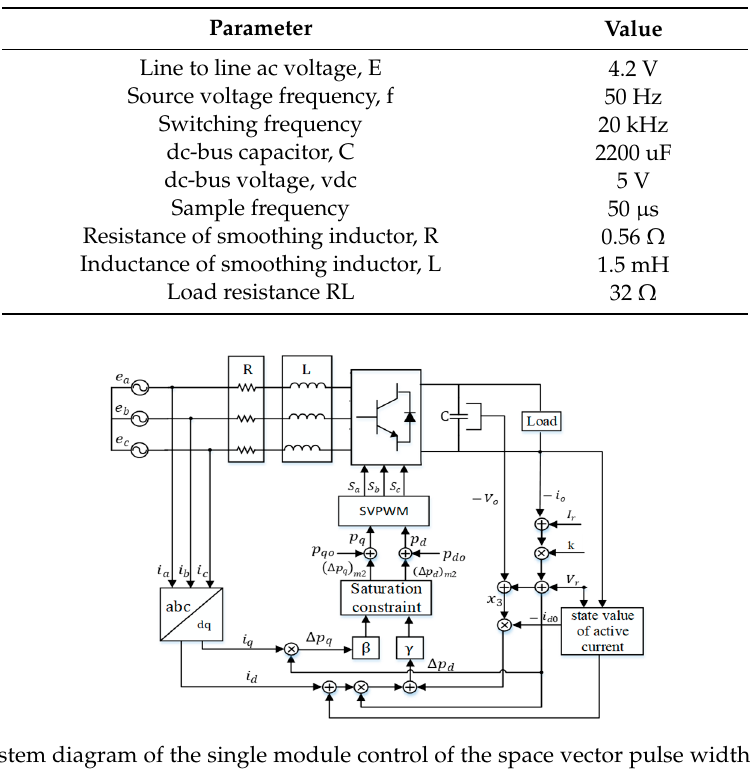
( b ) Figure 7. The three-module parallel simulation model: ( a ) The main circuit model of a three-module system during the parallel simulation; ( b ) control loop model of a three-module system during the parallel simulation. 3.1. The Control Based on the Lyapunov Algorithm Figure 8 shows the output voltage, current and AC side A-phase voltage and current response curves of the system during the load is 32 Ω . Figure 8a indicates that during the power-on process, the system voltage overshoot is 10%, the system reaches the steady state in 0.02 s and the output voltage is 5 V. Moreover, Figure 8b shows that the output current is 150A. Figure 8c shows the waves of the input. It is observed that the current fluctuates before 0.02 s and there is a short overshoot. Meanwhile, the system is stable after 0.02 s and achieves unit power factor. Figure 8d shows the spectrum of the A-phase current. It is found that the A-phase current contains low harmonics, where the total harmonic distortion (THD) rate is THD = 1.02%. ( a )